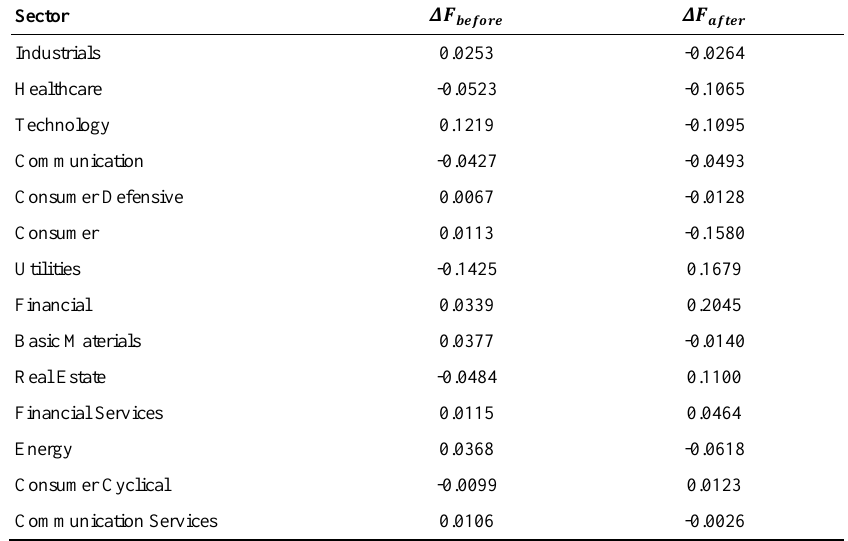
Table 13. The net information outflow for the sectors in S&P500 market, before and after COVID-19